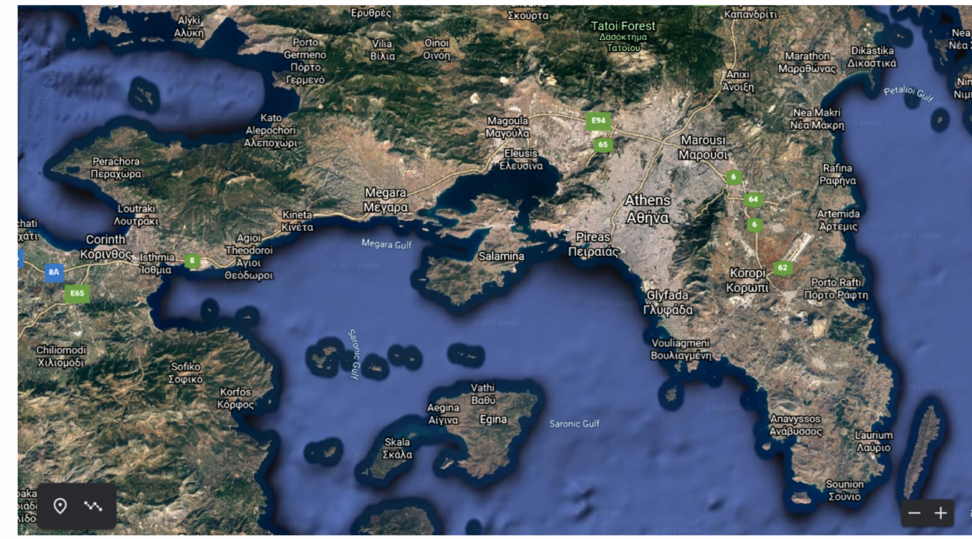
Figure 1. The sampling site and the industrial area in Eleusina nearby Athens (source: Google Maps).